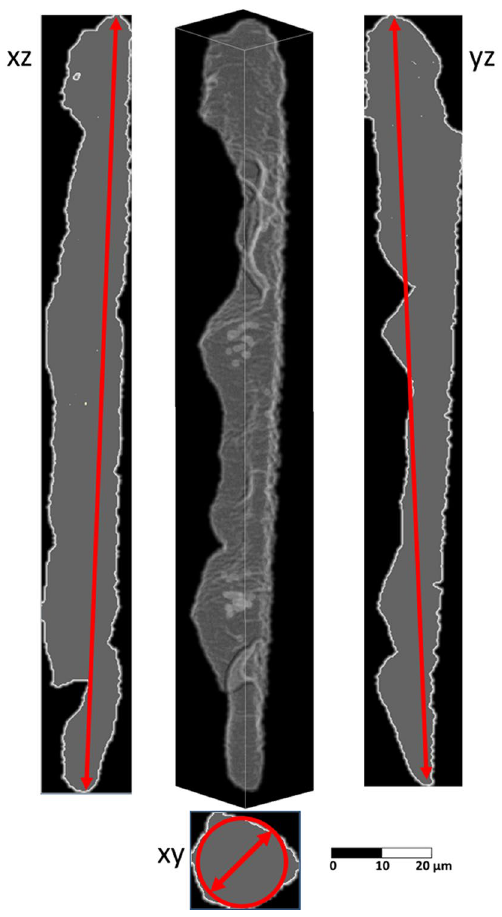
Figure 8. The 3D reconstruction of a sub-element void of S19 sample. The projections of the void are shown in grey. The length of the voids is estimated using the major axes of the projections on XZ and YZ planes, while the void diameter was calculated from the circle equivalent to the projection on the plane XY. The image was generated by using the Fiji distribution of ImageJ 40 . [ImageJ-1.53c https:// imagej. net/ ImageJ ].